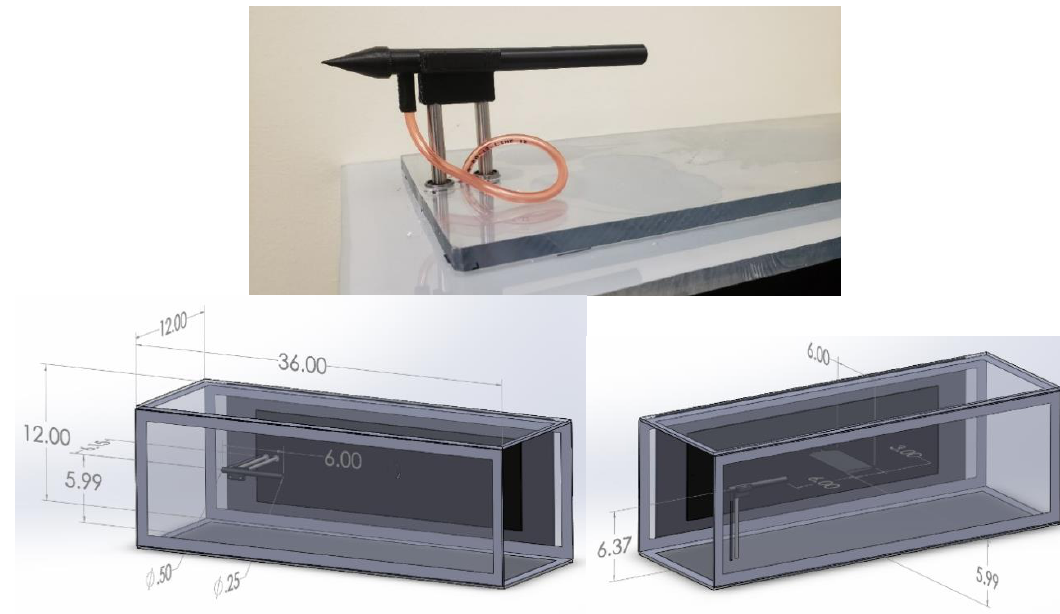
Figure 3. Photography of the pressurized vortex tube and its CAD model inside the wind tunnel and in a typical configuration upstream of an airfoil. Geometry and dimensions (inches) shown.